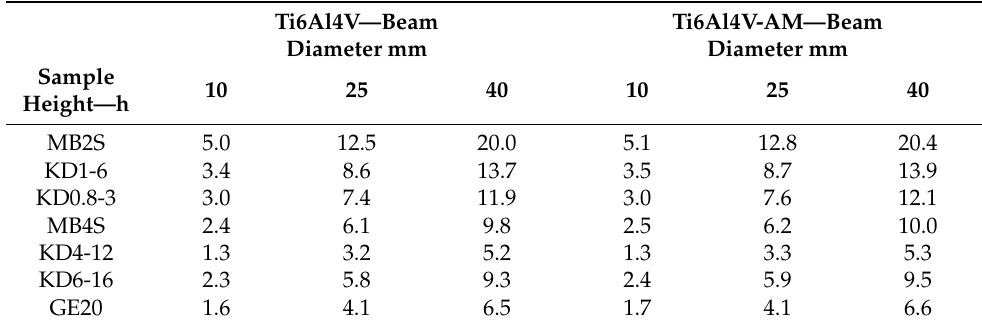
Table 3. The diameter of the ultrasonic wave beam B at the bottom of the tested